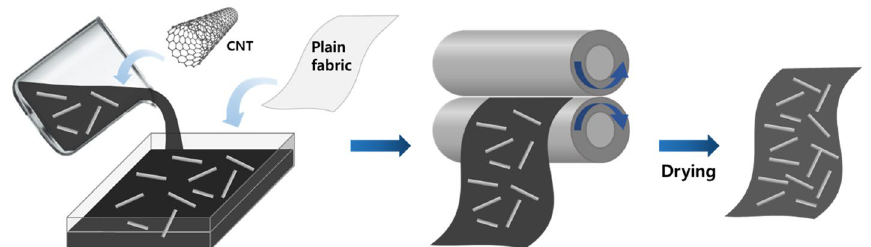
Fig. 4 Manufacturing process of the applying CNT to the plain fabric